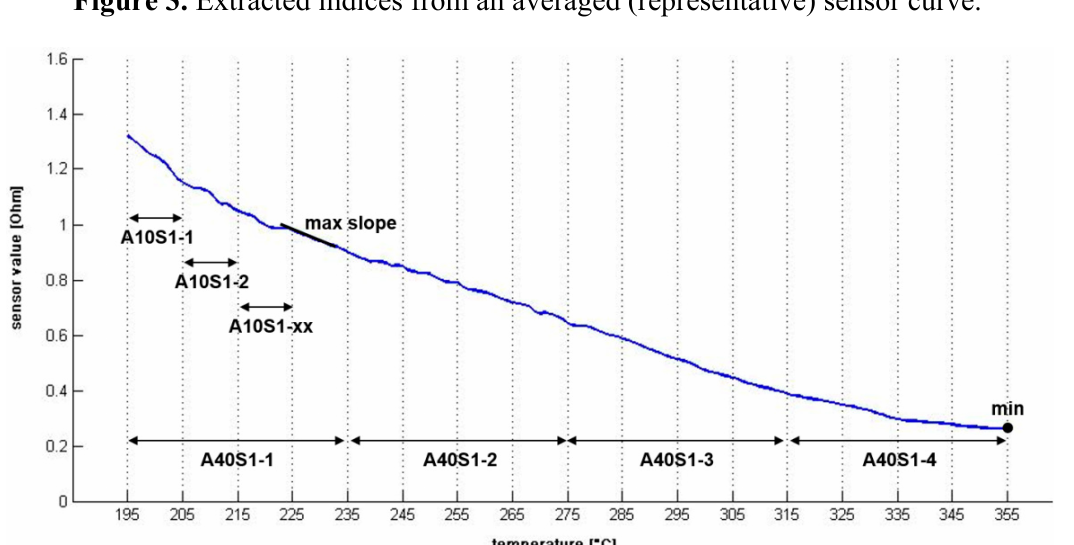
Figure 3. Extracted indices from an averaged (representative) sensor